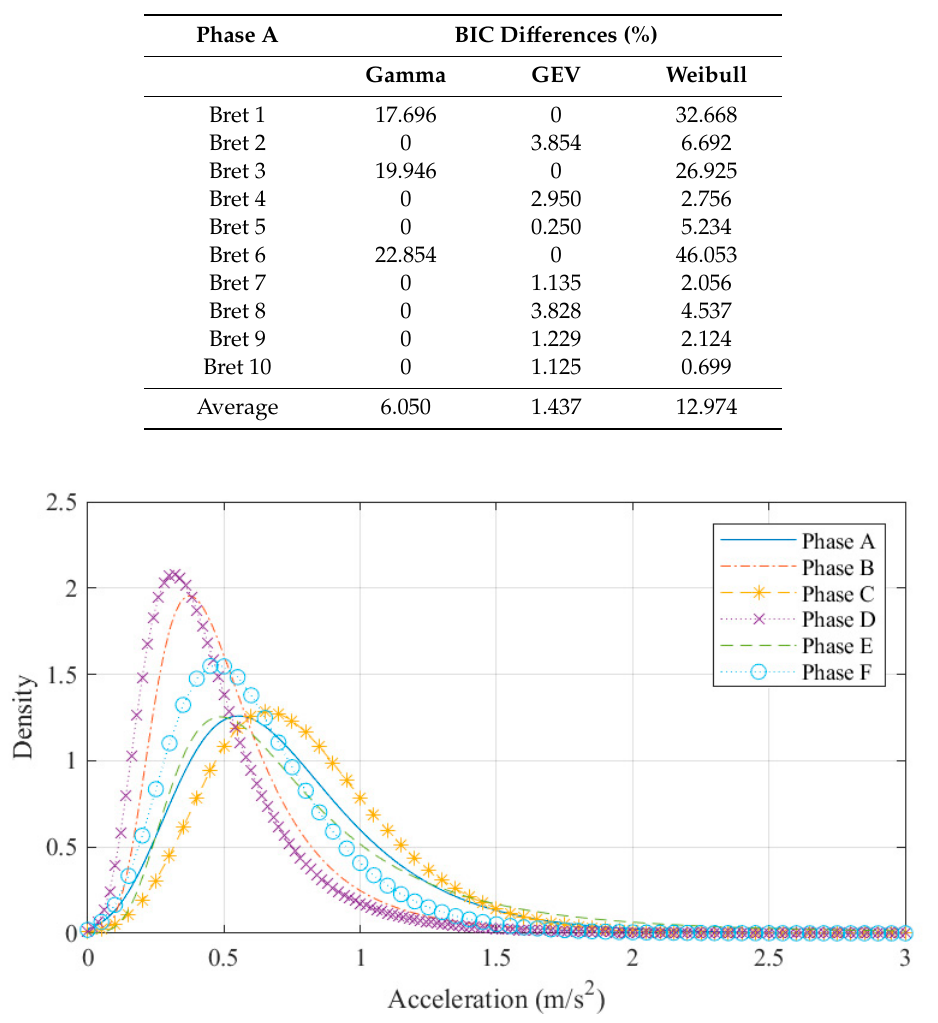
Figure 14. Comparison of gamma, general extreme value (GEV) and Weibull probability distributions fitted to acceleration responses for undamaged spar platform exposed to Bret 7 wave. Table 6. Percentage di ff erence of each Bayesian information criterion (BIC) value from best fit BIC value for di ff erent distributions for all Phase A tests.